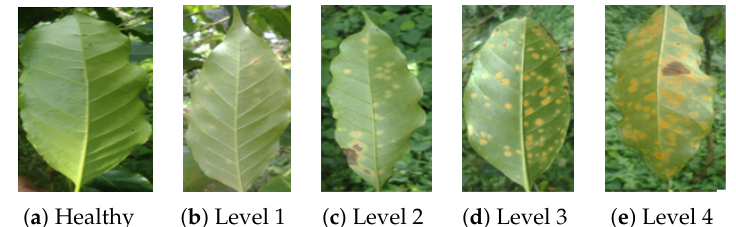
Figure 3. Different levels of coffee rust severity. The higher the level, the more the coffee leaf is affected by coffee rust. Level 1 implies that between 1% to 5% of the leaf has rust, level 2 means that between 6% to 20% of the leaf is affected, level 3 has an affectation between 21% to 50% of the leaf, while level 4 implies that more than 50% of the leaf has rust.